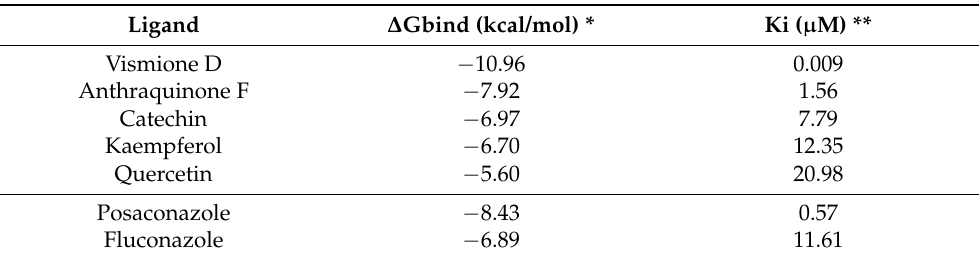
Table 5. Free binding energies and inhibition constants between fourteen compounds identified in Vismia guianensis extract and CaCYP51, obtained through molecular docking.